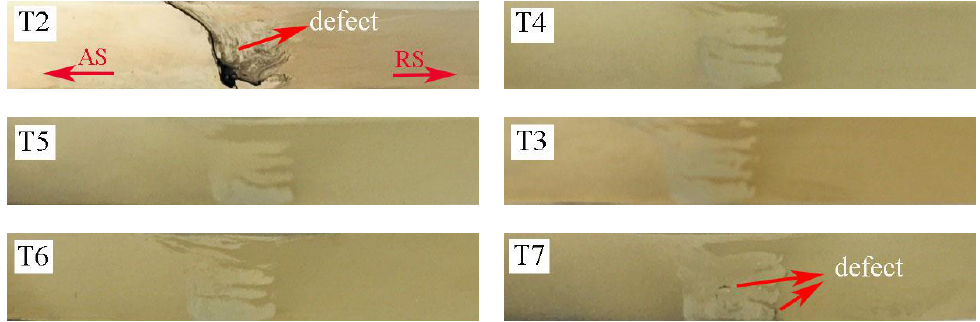
Figure 3. Morphologies of cross-section with different tool offset.